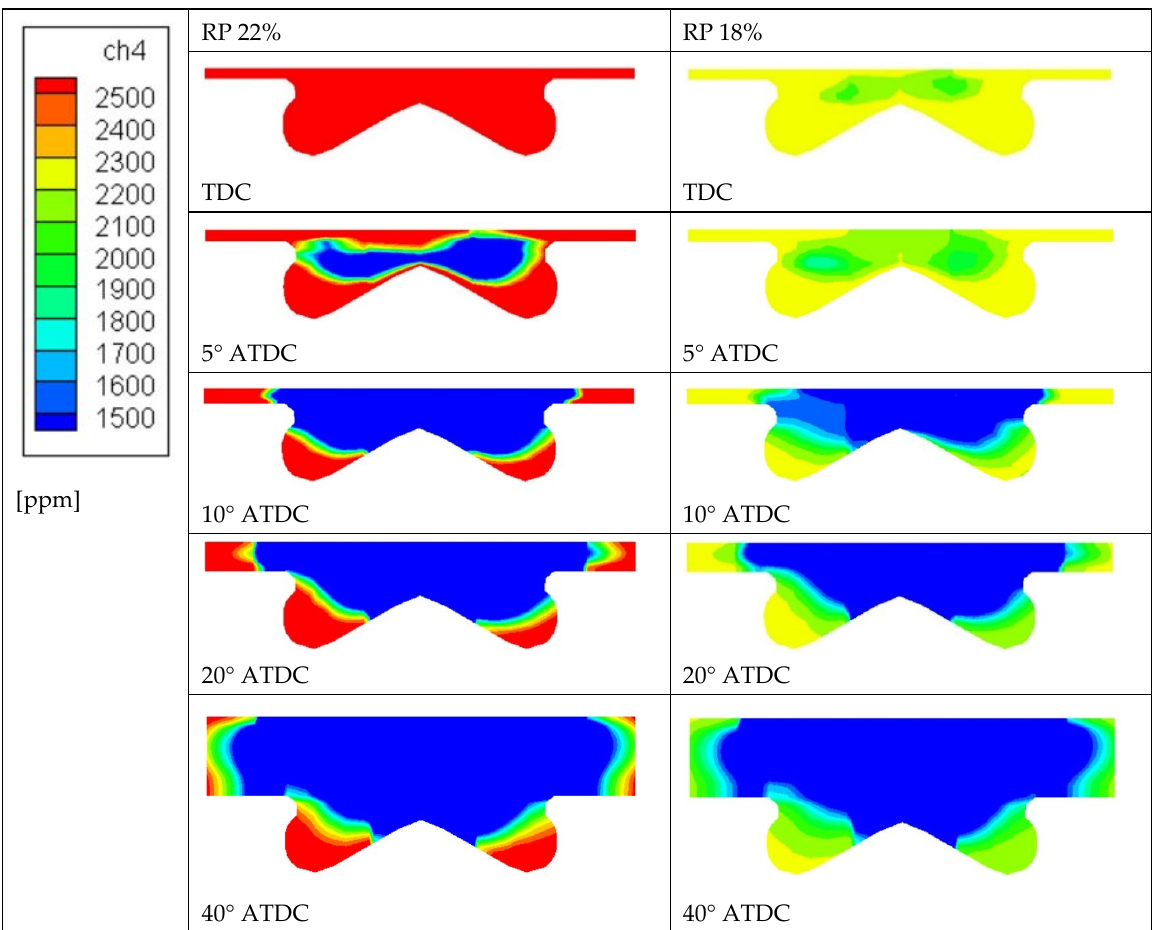
Figure 17. Methane mass fraction contours for RP = 22 and 18% at 2000 rpm.